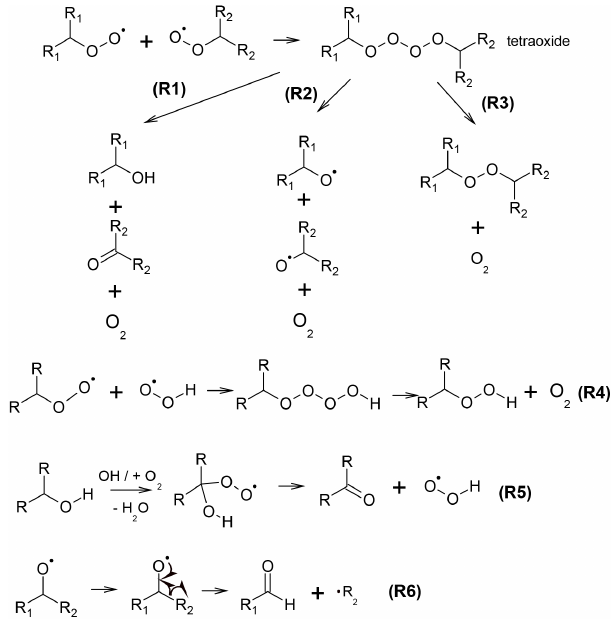
Figure 4. Sample reaction mechanisms that give rise to the + O and − 2H trends. The tetroxide intermediate forming from two alkylper- oxy radicals can result in a variety of products as shown in (R1) to (R3), among which (R1) can lead to formation of the hydroxyl func- tional group. A hydroperoxy functional group can be formed from RO 2 + HO 2 (R4). The hydroxyl-to-carbonyl conversion shown in (R5) is likely responsible for the − 2H trend. Alkoxy radicals trig- ger bond-scission reactions and give rise to an aldehydic compound